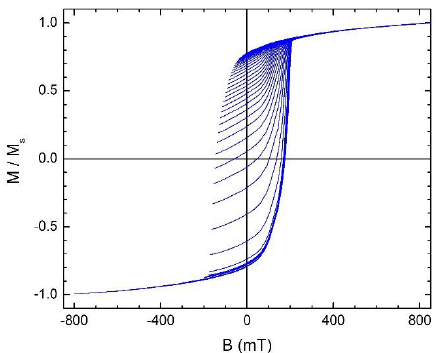
Figure 1. A set of measured first order reversal curves plotted in normalized magnetization vs. applied magnetic field.